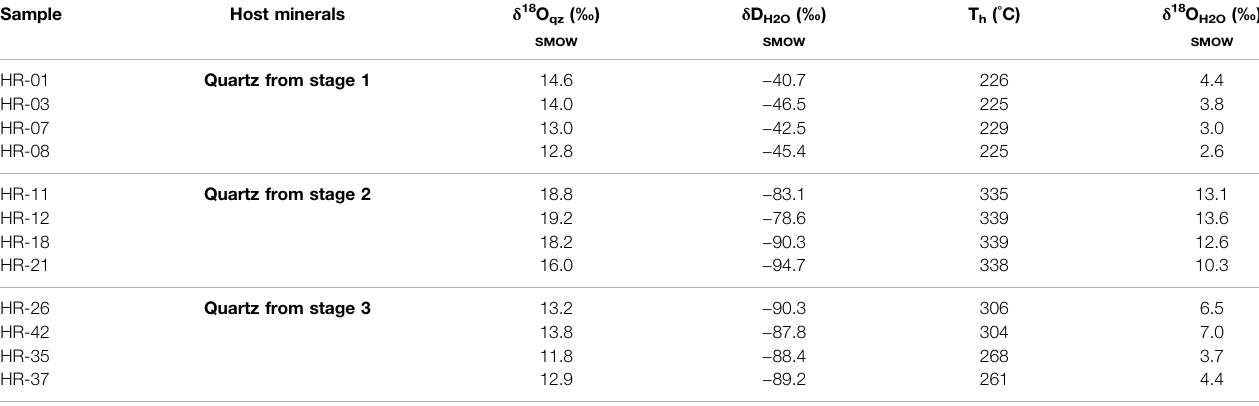
TABLE 2 | Oxygen and hydrogen isotope data from quartz and calcite of the Haerdaban Pb-Zn deposit. Sample